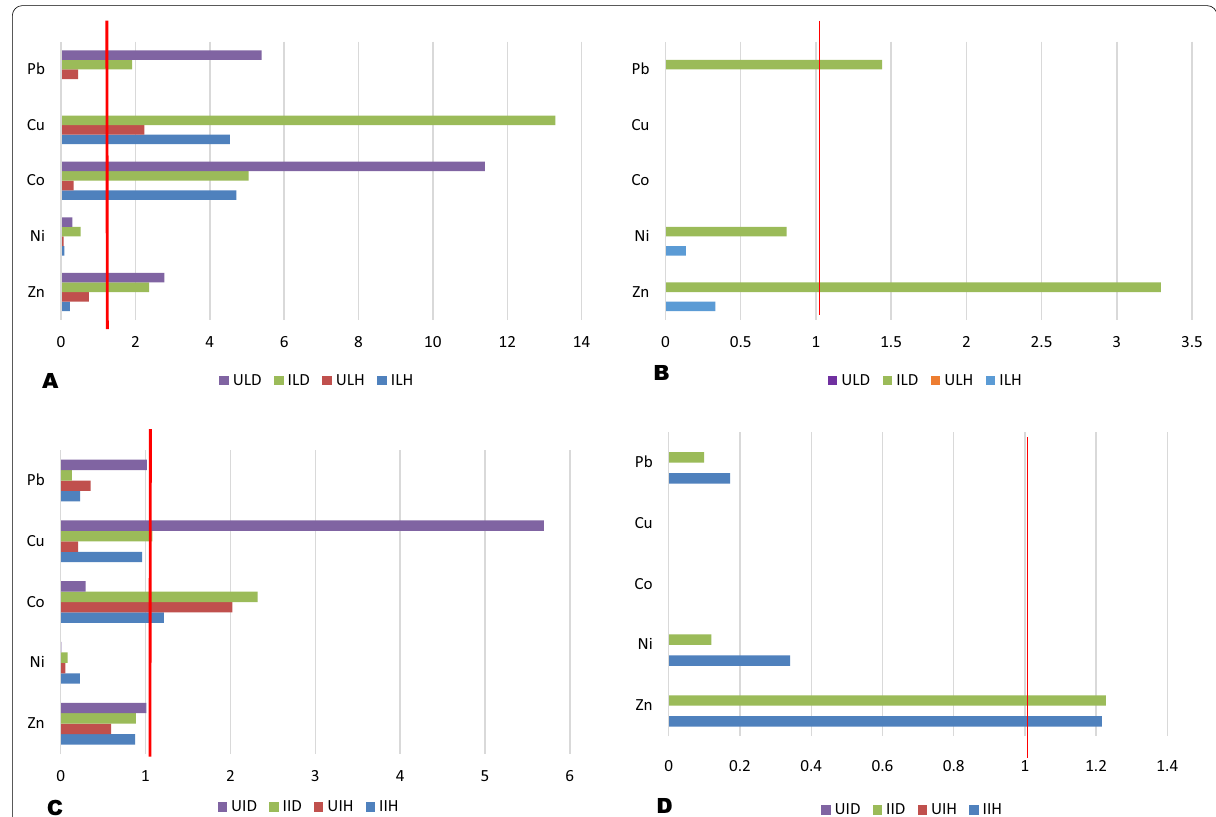
Fig. 3 Bioaccumulation of trace metals in toad Schlerophrys regularis and its enteric parasite Cosmocerca sp. A accumulation factor, B liver/ parasite bioaccumulation factor, C intestine/ sediment biota-sediment accumulation factor, D = = bioaccumulation factor. Keys: ULD uninfected liver at the dumpsite, ILD infected liver at the dumpsite, ULH = = UID uninfected intestine at the dumpsite, IID infected intestine at the dumpsite, UIH uninfected intestine at habitat, IIH = = =